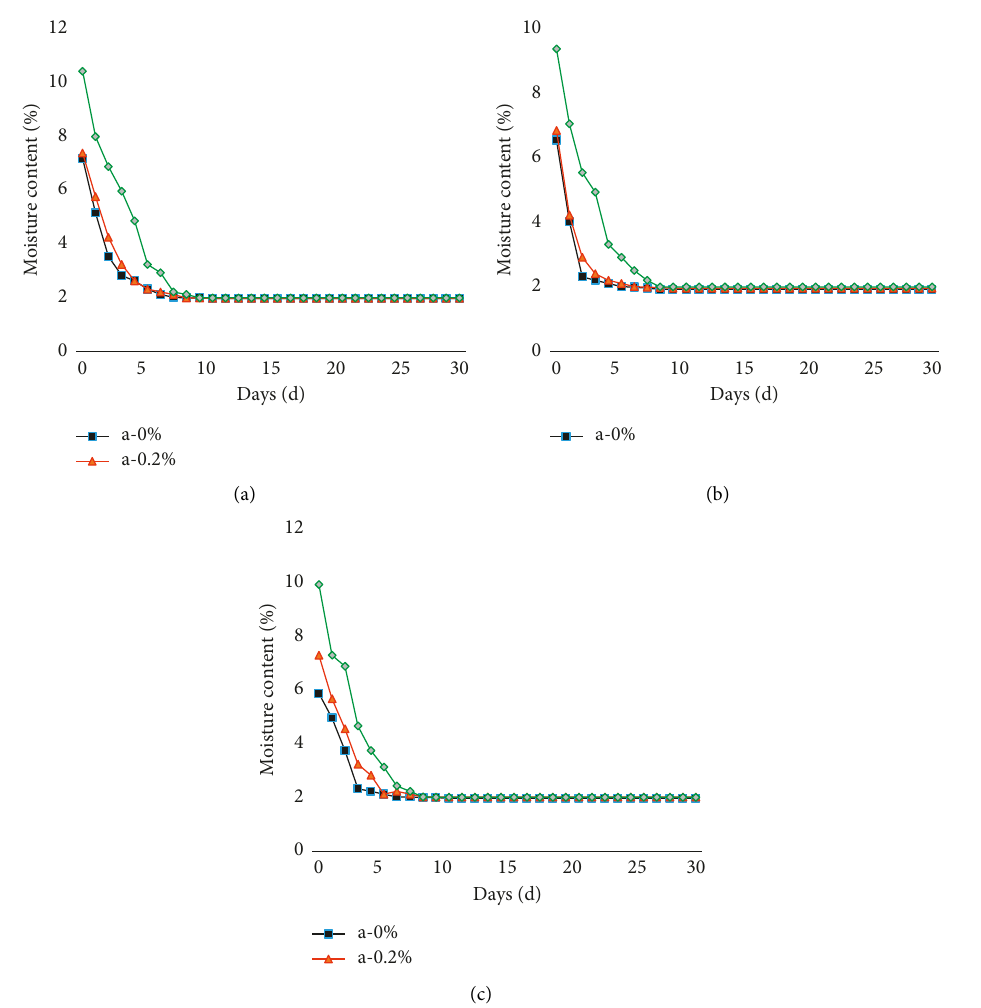
Figure 2: Variation curve of sample moisture content with